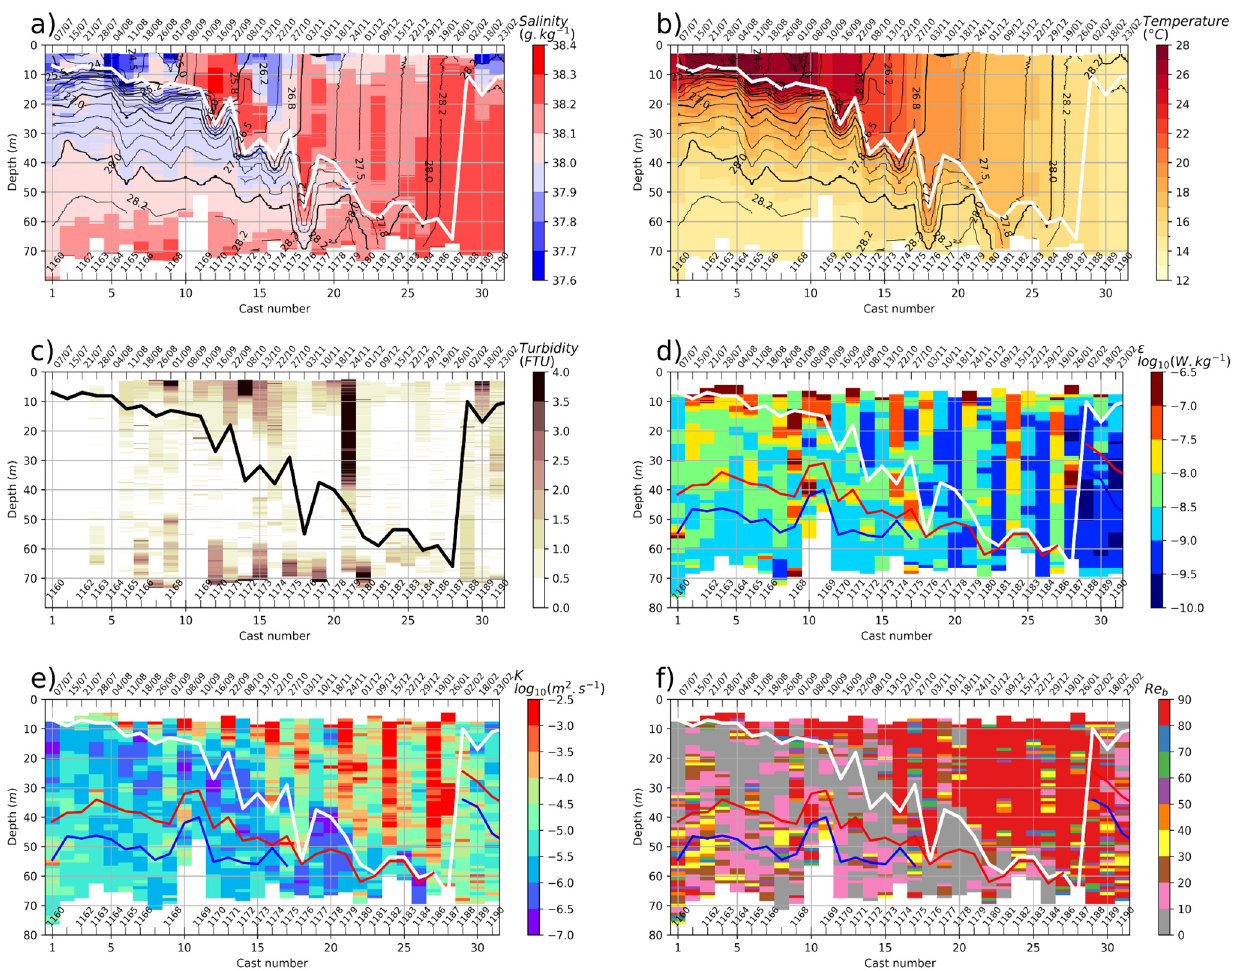
Figure 2. Temporal sequences of the vertical profiles of ( a ) salinity and density (black contours), ( b ) temperature and density (black contours), ( c ) turbidity, ( d ) dissipation rates of turbulent kinetic energy, ( e ) diffusion rates of turbulent kinetic energy, and ( f ) the buoyancy Reynolds number. MC casts are indicated over the cast number. Dates are shown on the upper x-axis. For all plots: main thick line indicates the MLD , red and blue lines indicate the average depth of the 1st and 2nd baroclinic modes, respectively.